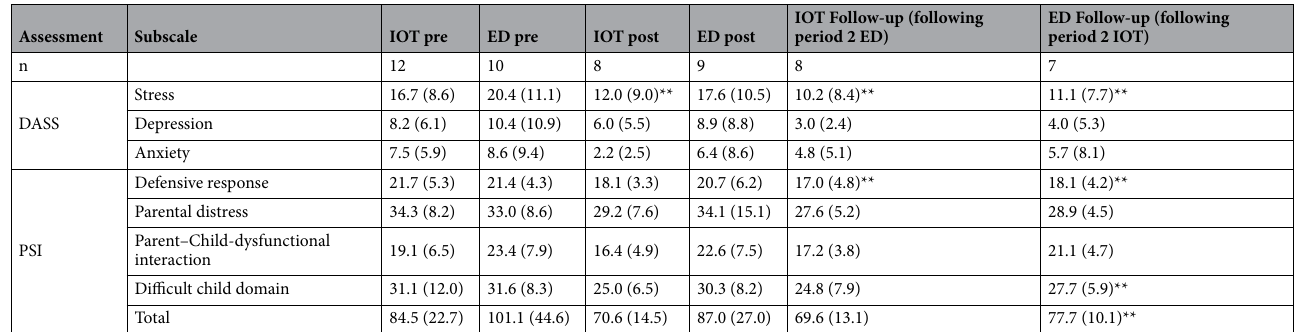
Table 2. Descriptive statistics for the mental health outcome measures. IOT insight oriented psychotherapy, ED education. ** p < 0.05 for paired t-test with pre score. Data presented as mean (sd), or